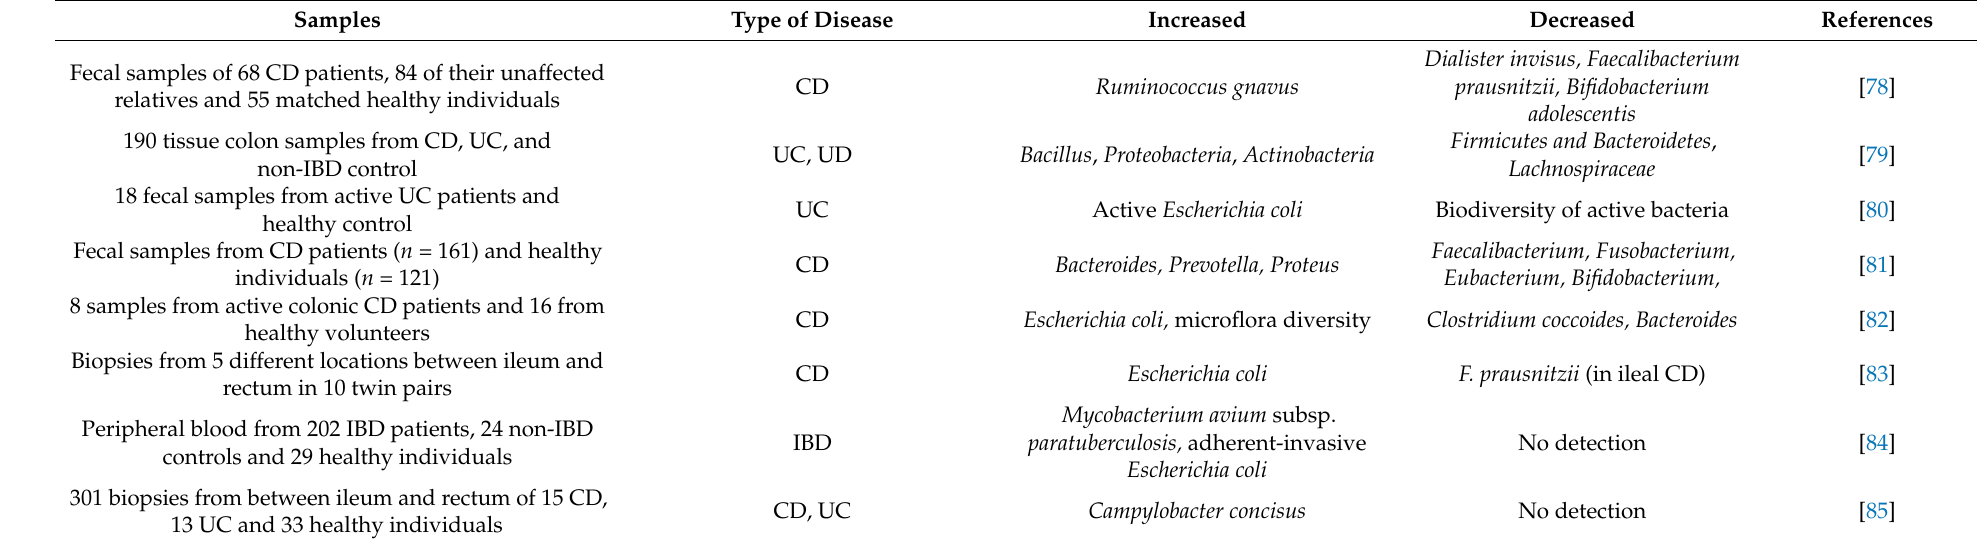
Table 2. Microbiome alterations during inflammatory bowel disease